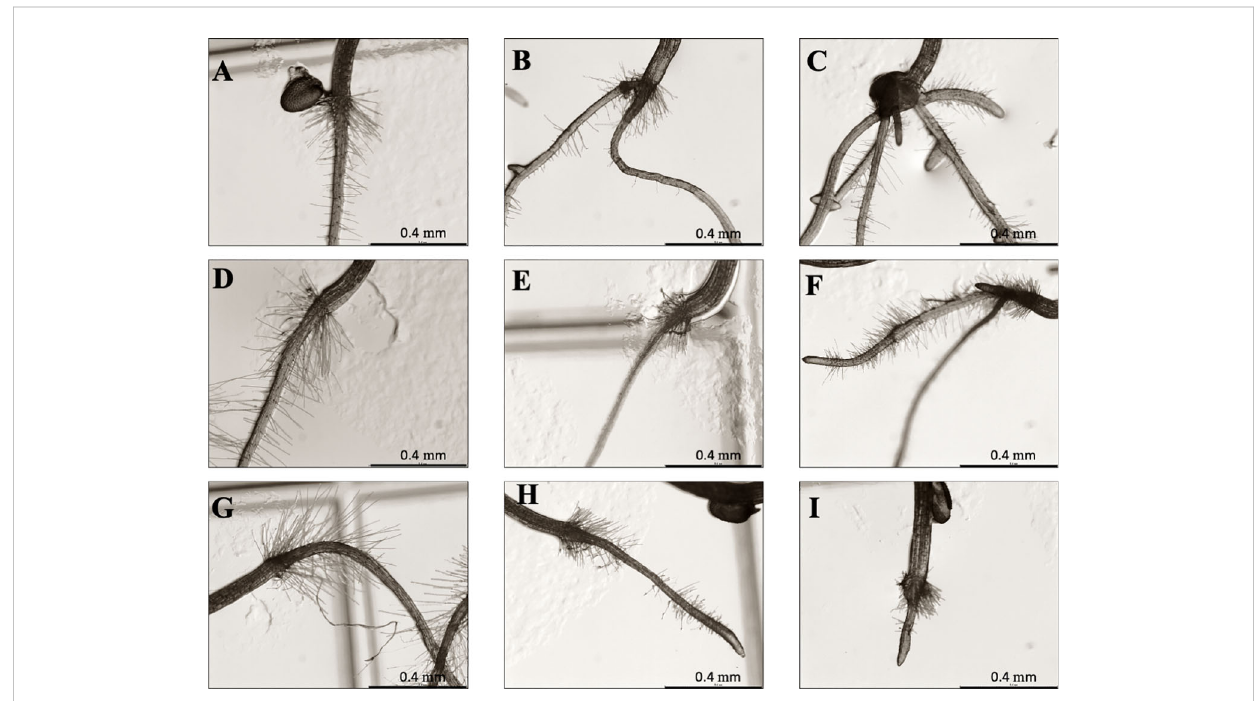
FIGURE 6 Arabidopsis roots after 14 d of PCIB bioassay. (A) Control, (B) IC TC, (G) 30 m M PCIB, (H) 30 m M PCIB + IC 50 TC, (I) 30 m M PCIB + IC 80 TC. Scales bar: 400 m